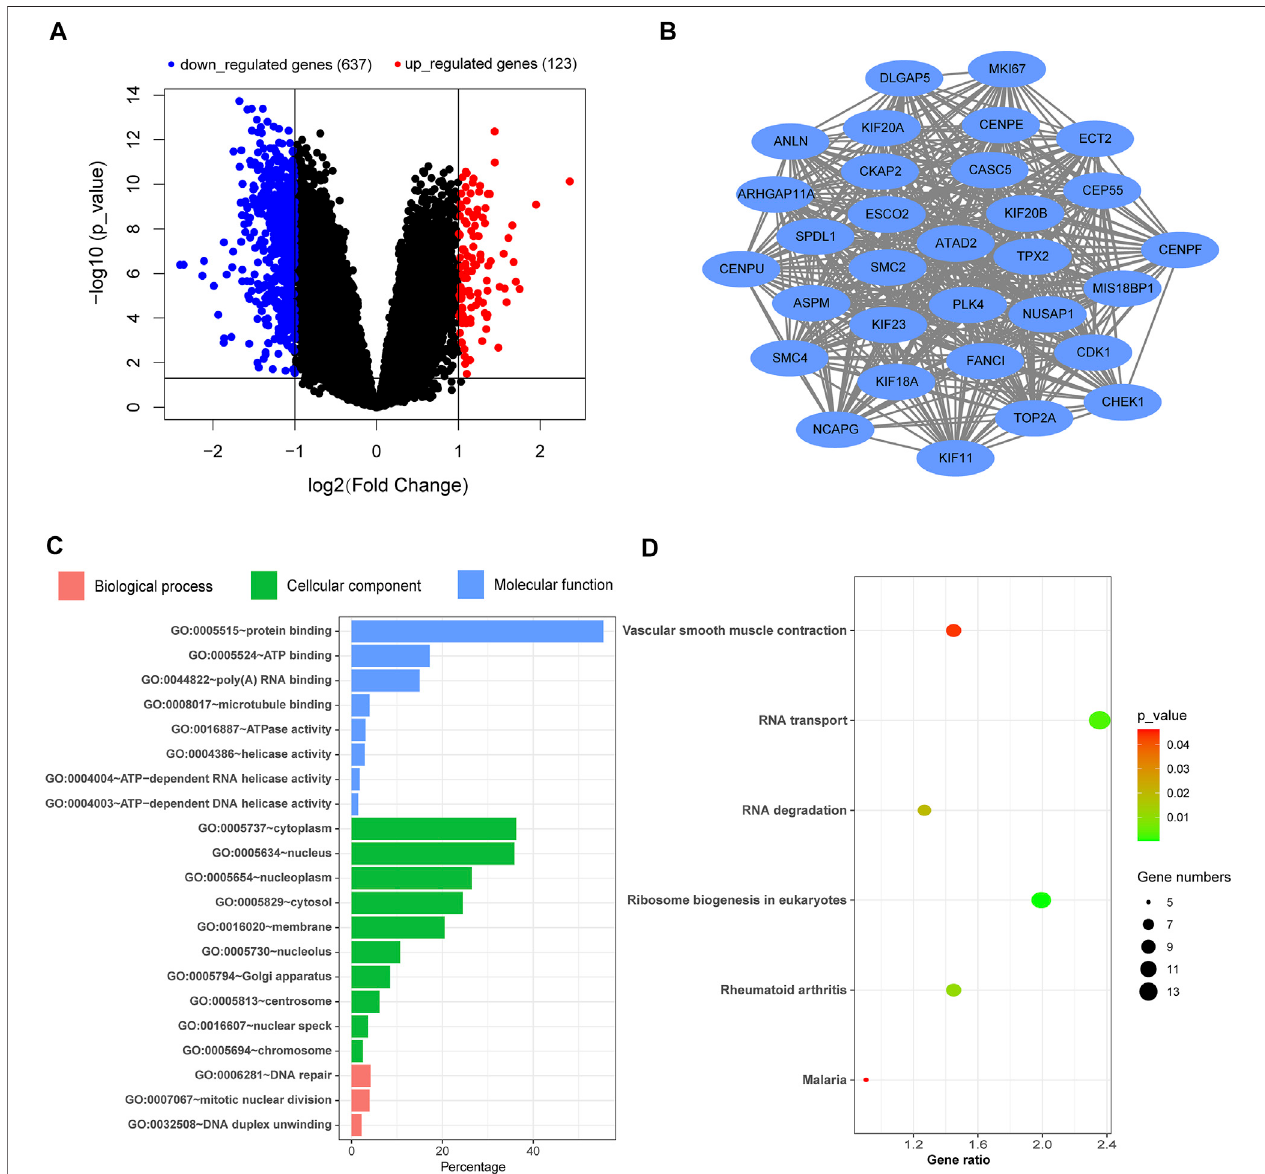
FIGURE 1 | Analysis of the gene expression pro fi le dataset related to pulmonary hypertension (GSE113439). (A) Volcano map. The red points represent upregulated genes selected based on the corrected p-value < 0.05 and logFC > 1. The blue points represent downregulated genes selected based on the corrected p-value < 0.05 and logFC < − 1.Theblack points represent genes withno signi fi cantdifference. (B) Themost signi fi cant module wasobtained from thePPI network. (C) GOenrichmentanalysisof DEGs. (D) KEGG pathway analysisof DEGs. FC, fold change;GO, GeneOntology; DEGs,differentially expressed genes;KEGG, Kyoto Encyclopedia of Genes and Genomes; PPI, protein – protein